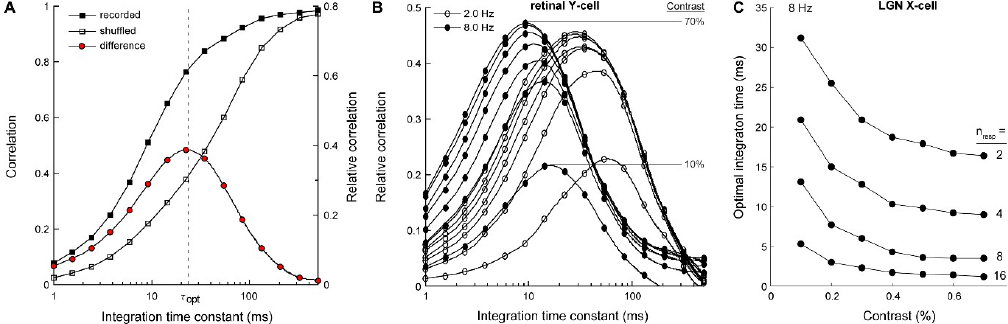
Figure 3. Computing the optimal integration time across stimulus conditions. ( A ) From the difference between the correlation curve for the recorded (solid squares) and shuffled spike trains (open squares) we obtained a relative correlation curve (red circles; see Model for details). We defined the optimal integration time ( τ opt ) as the time constant where the relative correlation curve peaks. At this integration time, the correlator best extracts motion information from the temporal structure of the input spike trains. Optimal integration times were computed in Matlab, following cubic spline interpolation of the 15 data points. ( B ) Relative correlation curves based on the data partially displayed in Figures 1 and 3A. τ opt decreases with increasing temporal frequency. Contrast (10–70%) determined total correlation (peak height), but above about 10% had little effect on τ opt . ( C ) τ opt for a LGN X-cell computed by combining increasing numbers of spike responses. For instances 4–16, spike responses were combined additively prior to temporal filtering and pairwise cross-correlation.